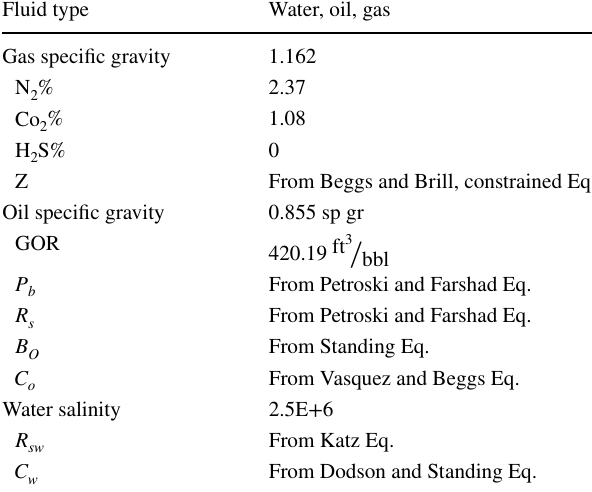
Table 1 Perforation intervals From the starting point of the perforated area